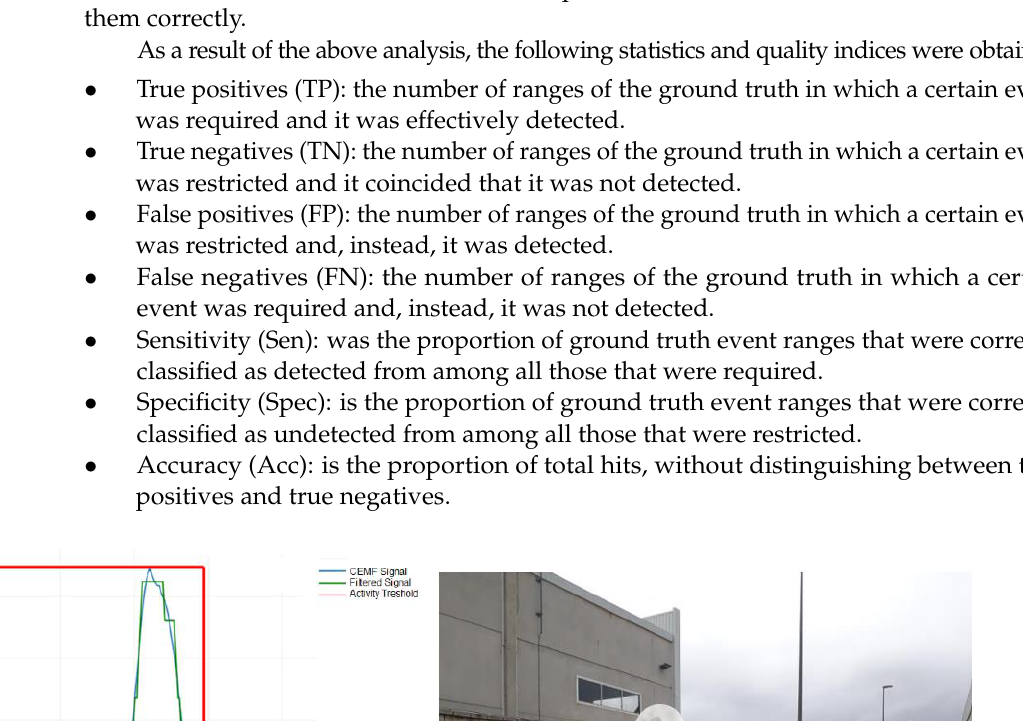
Figure 29. Image validating of a CEMF event in the field.